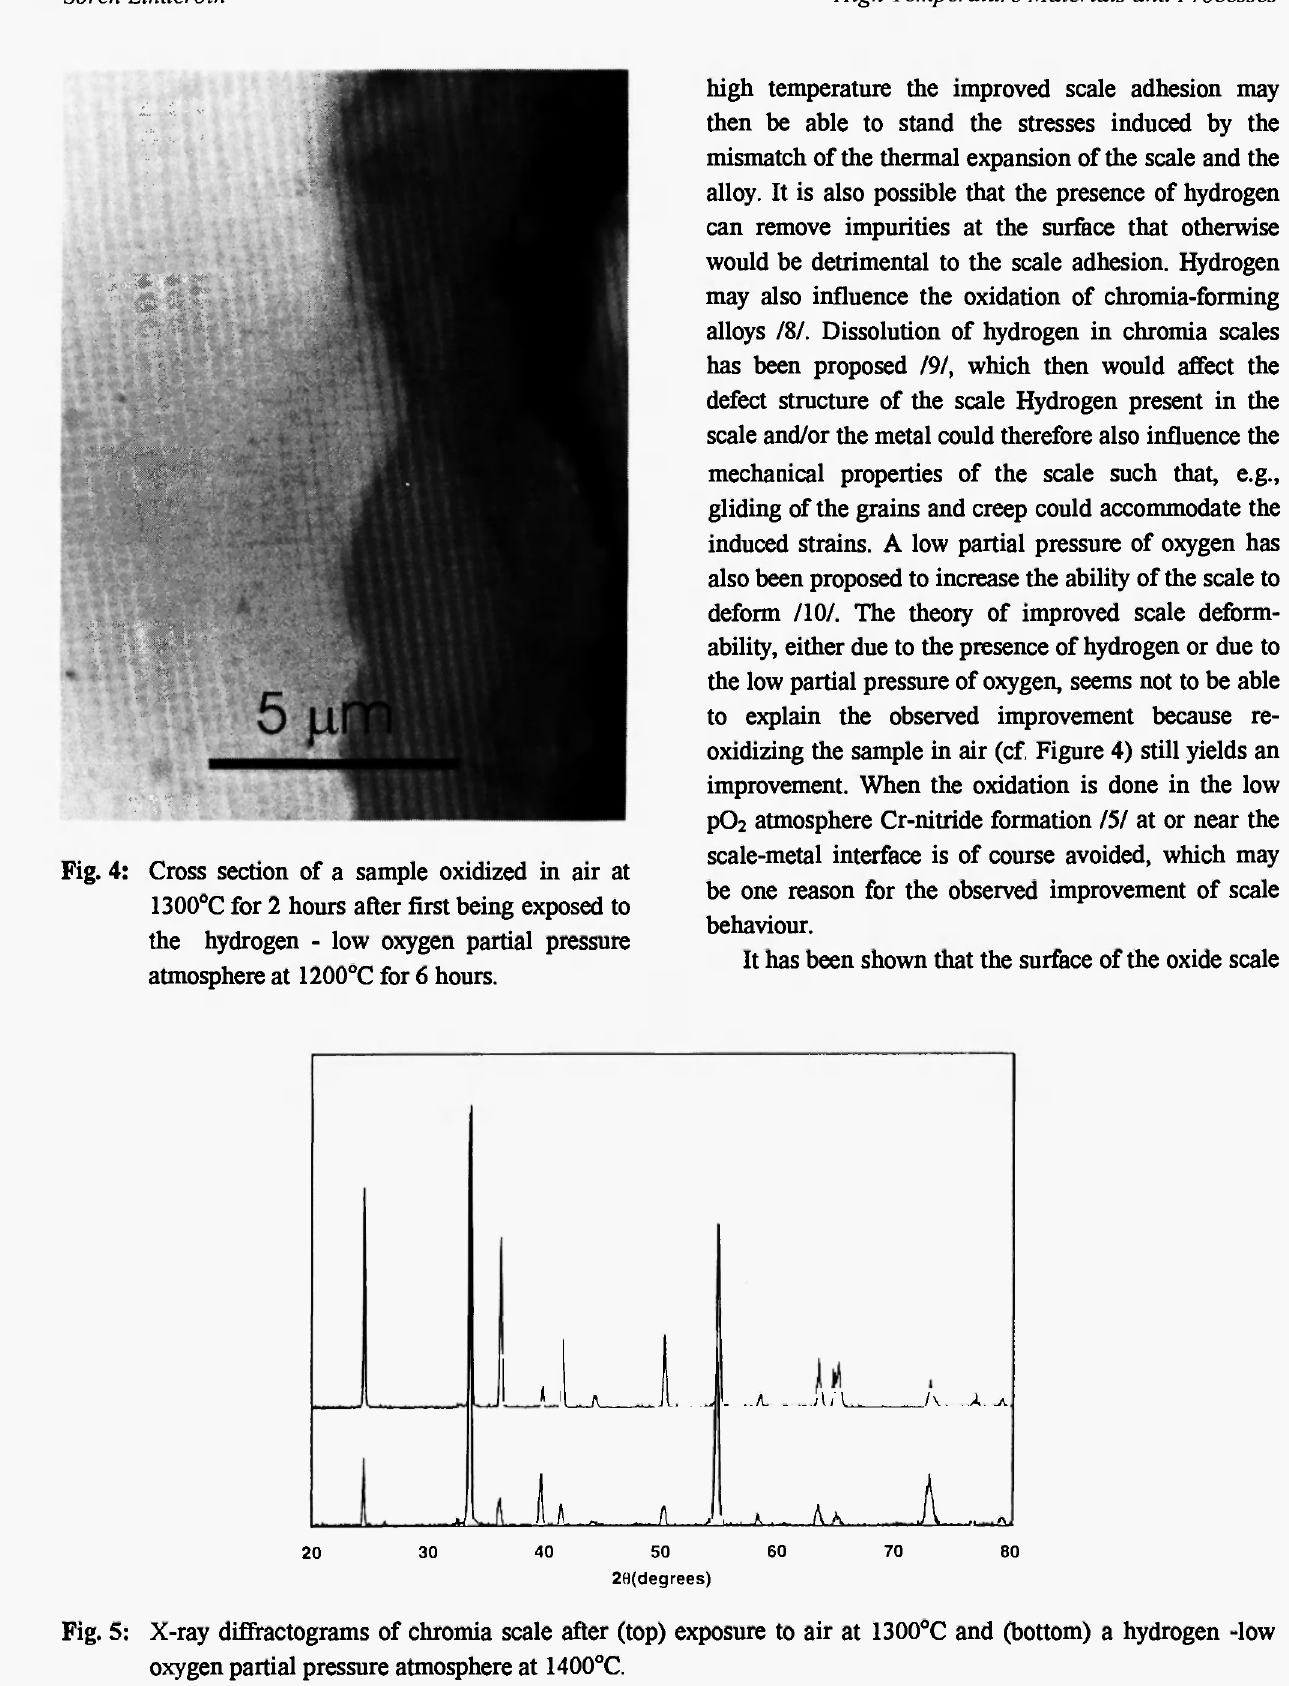
Fig. 5: X-ray difitactograms of chromia scale after (top) exposure to air at 1300°C and (bottom) a hydrogen -low oxygen partial pressure atmosphere at